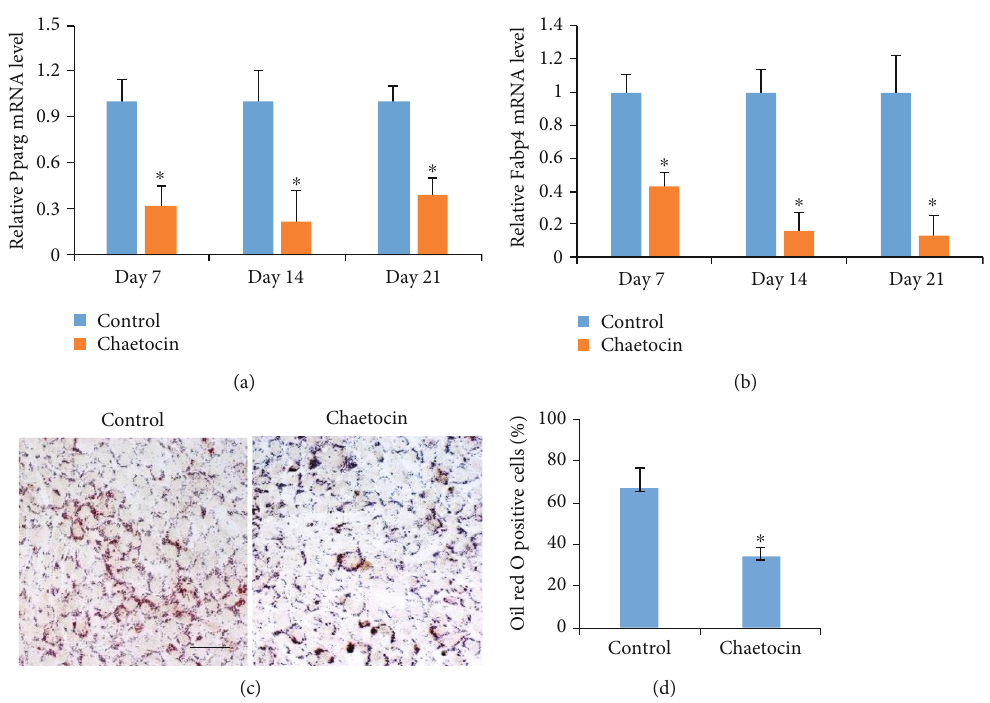
Figure 2: E ff ect of Chaetocin on MSC adipogenic di ff erentiation. (a, b) Real-time RT-PCR analysis shows that expression adipogenic markers (Pparg, Fabp4) was signi fi cantly inhibited by treatment with Chaetocin. (c, d) Oil red O staining showed a signi fi cant decrease of oil droplets in MSCs treated with Chaetocin. PCR and quanti fi cation data are as expressed as means ± s : d : of three independent experiments ( ∗ p < 0 : 05 ). Scale bar: 500 μ